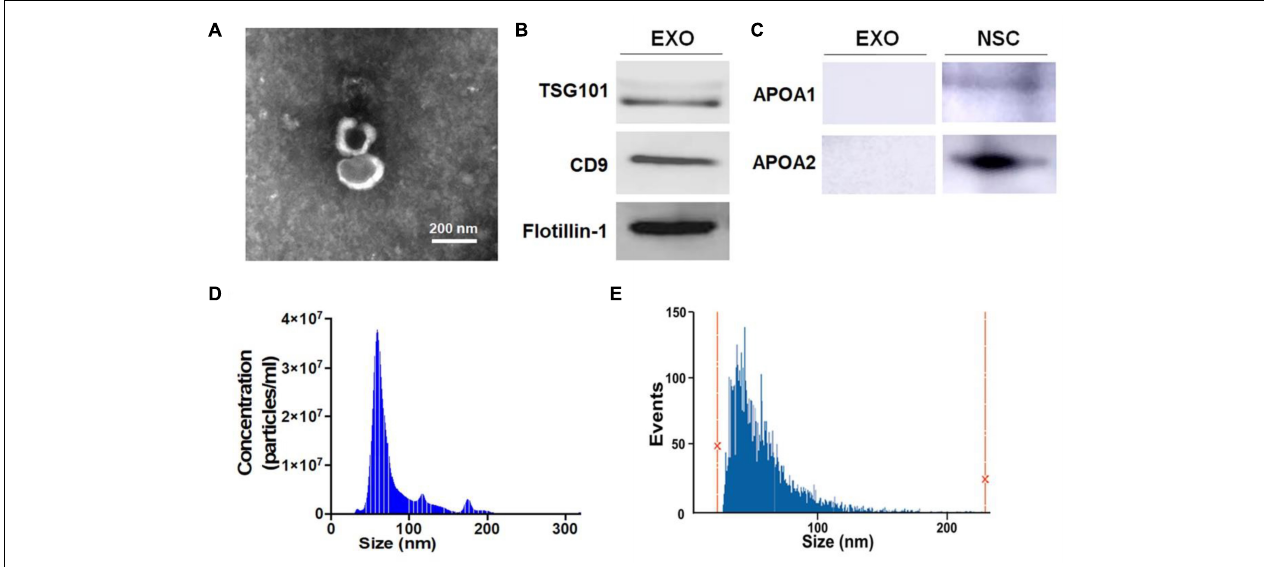
FIGURE 1 | Characterization of exosomes (EXOs). (A) Purified exosomes were observed under transmission electron microscopy (TEM) using negative staining. (B) The levels of positive exosomal markers TSG101, CD9, and Flotillin-1 in protein lysates of neural stem cells (NSC)-derived exosome pellets were determined by western blotting. (C) The levels of negative exosomal markers APOA1 and APOA2 in protein lysates of NSC-derived exosome pellets and NSCs were determined by western blotting. (D,E) Particle-size distribution of exosomes was determined by NanoSight analysis (NTA) in panel (D) and NanoFCM in panel (E) technologies. Scale bar 200 nm in panel (A)